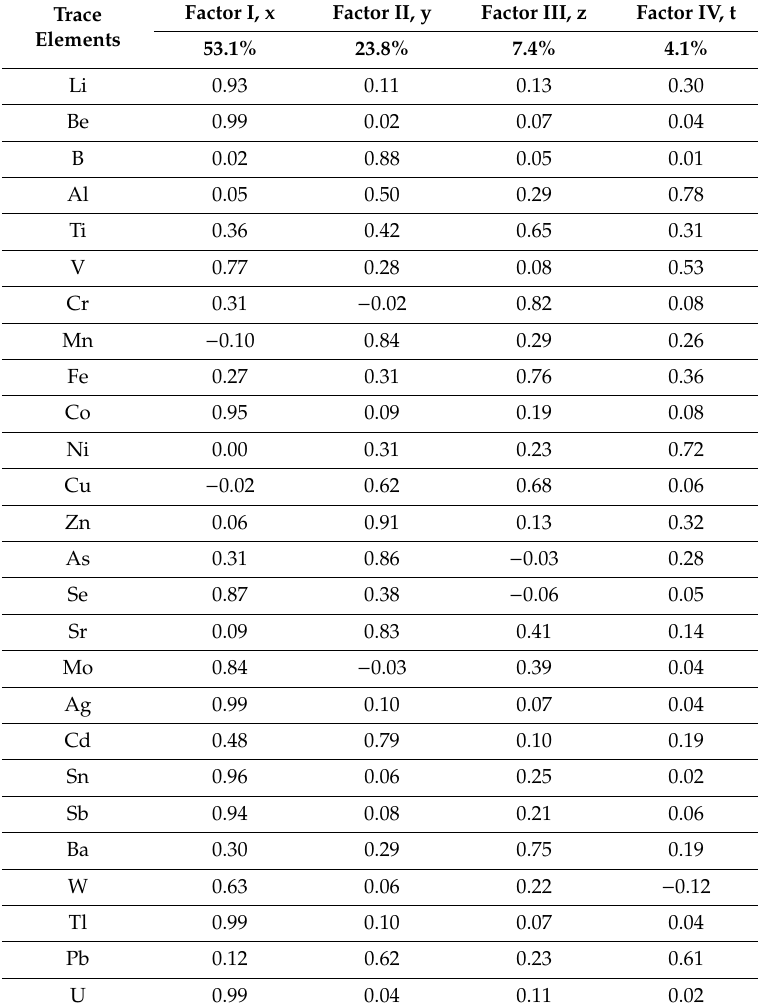
Table 8. Factor loadings of the analyzed elements in the aerosol of the atmospheric near-water layer above Lake Baikal along the route of the RV «Akademik V.A. Koptyug» from 24 July to 4 August 2019 (The contribution of the factor to the total variance is indicated in the table below the names of the